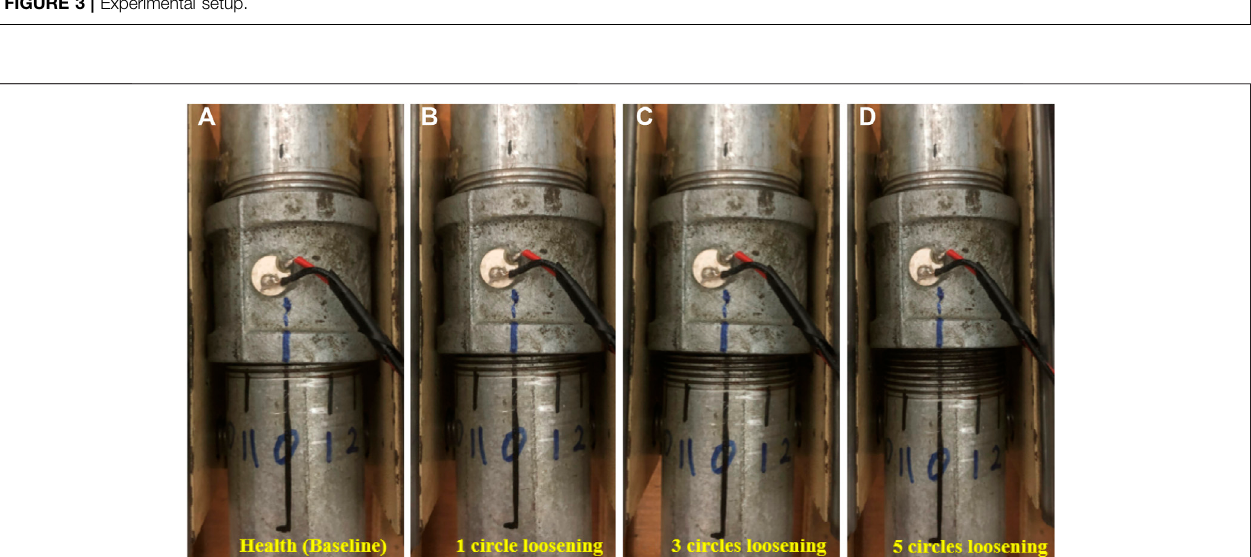
FIGURE 4 | Several loosening severities for (A) health (baseline), (B) one circle, (C) three circles and (D) fi ve circles of loosening.